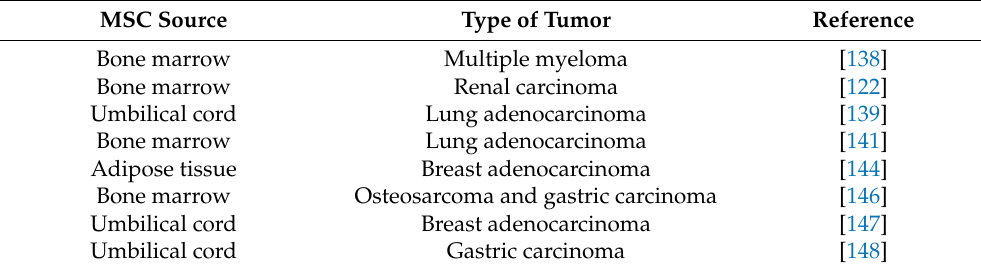
Table 2. Summary of current data on the effect of EVs on tumor